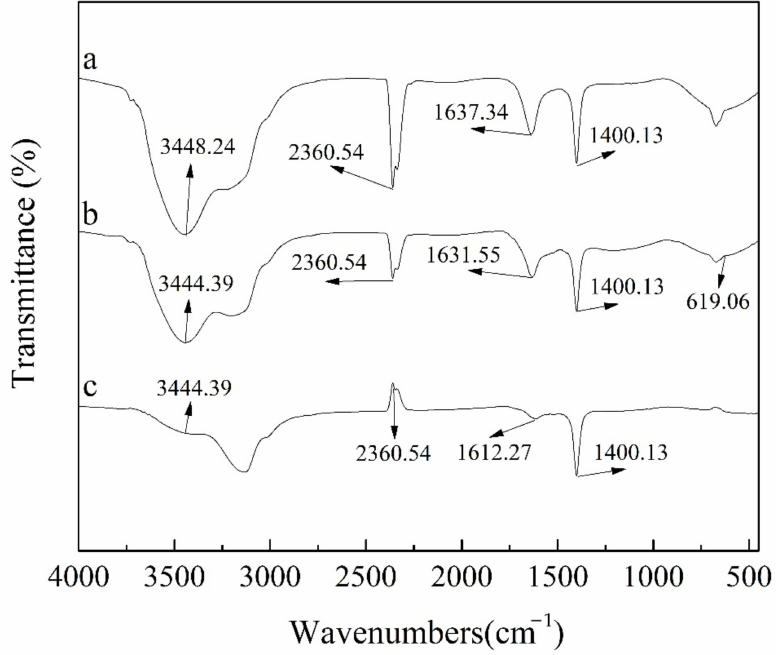
Figure 3. FTIR image: ( a ) AC, ( b ) Co@AC before reaction, ( c ) Co@AC after reaction (The preparation conditions of Co@AC: Co 2+ mass fraction 7%, immersing time 7.0 h, calcining temperature 500 ◦ C, calcination time 4.0